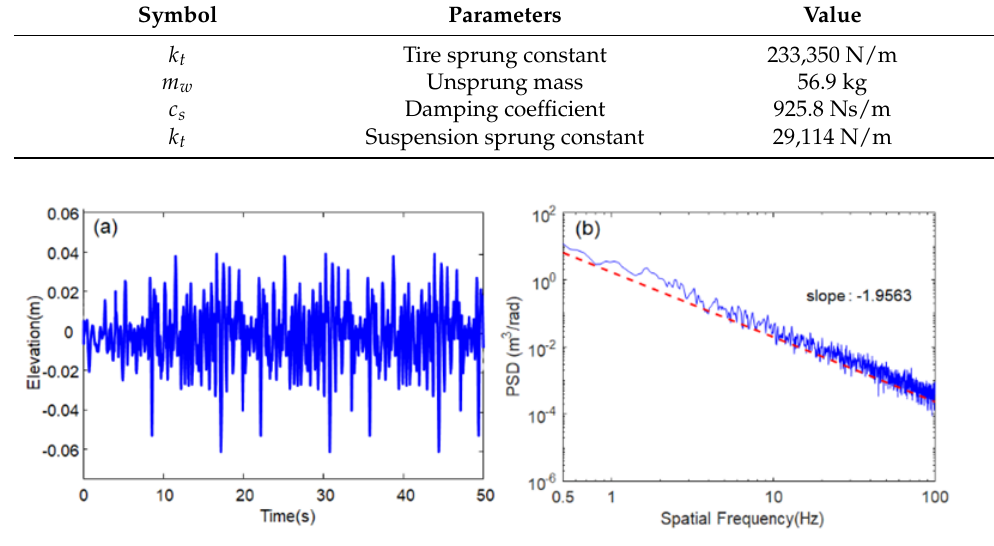
Figure 4. Unknown road roughness input for simulation; ( a ) measured road roughness at a vehicle speed of 20 km/h for 40 s and ( b ) its power spectral density function.